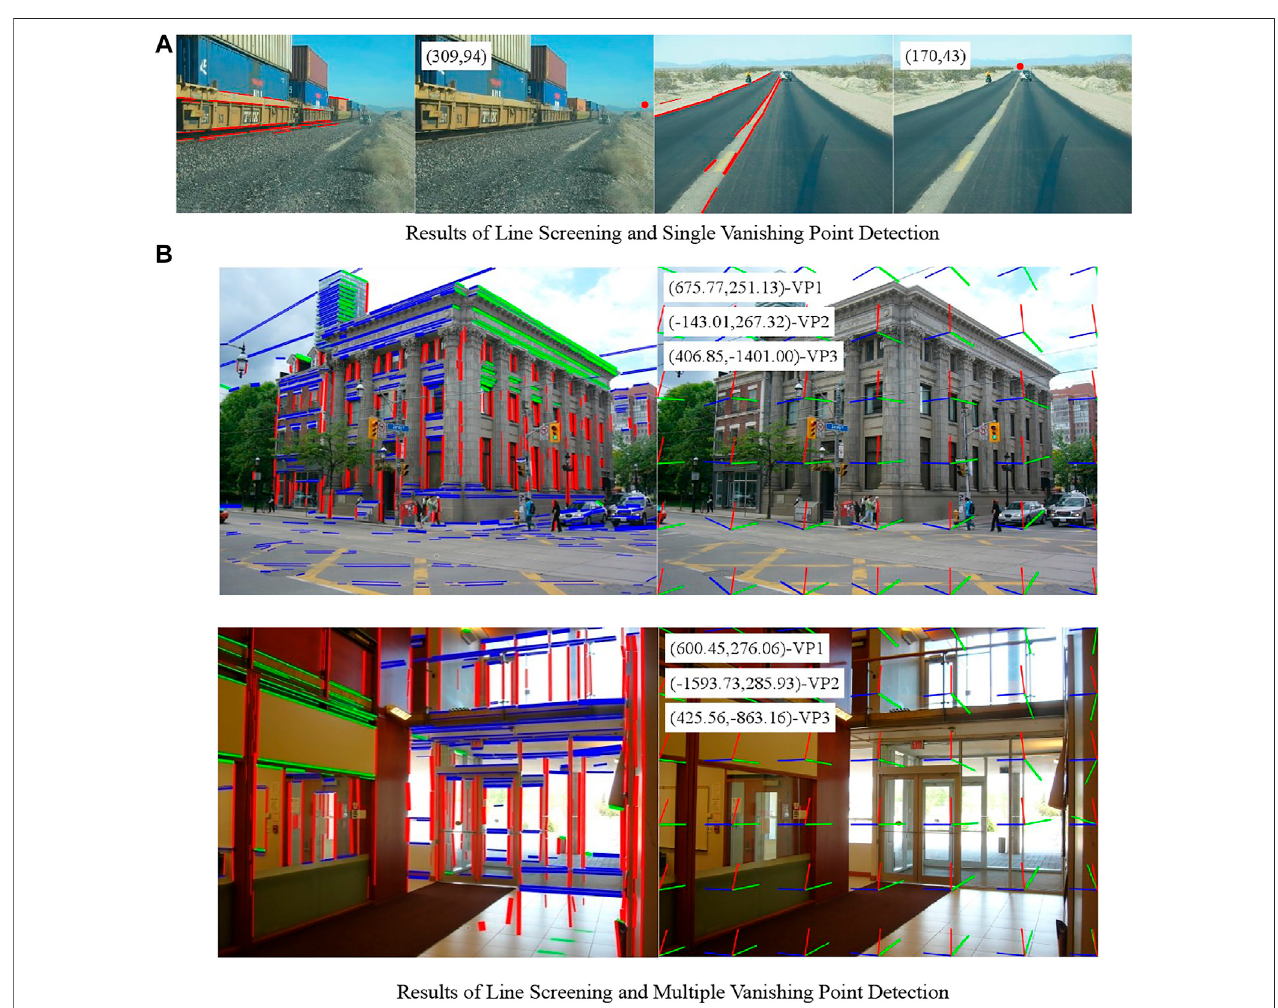
FIGURE11| Results oflinescreeningandvanishingpoint detection. (A) Resultsoflinescreeningand singlevanishingpoint detection. (B) Results oflinescreening and multiple vanishing point detection.